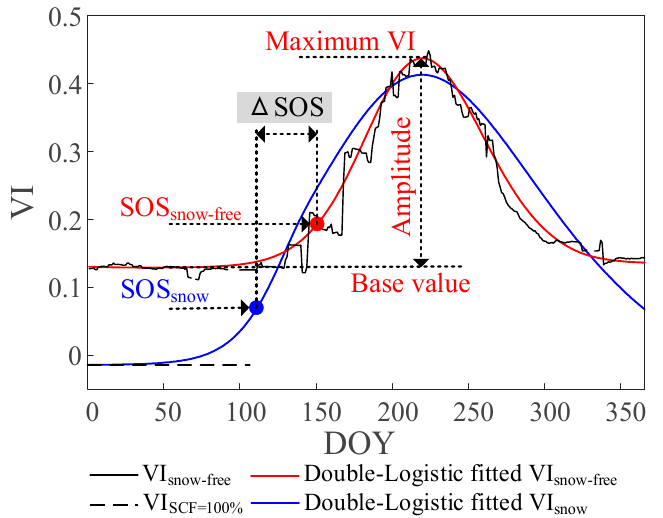
Figure 2. A schematic diagram of how the dynamic threshold method detects the start of the season (SOS). Δ SOS = SOS snow − SOS snow-free .